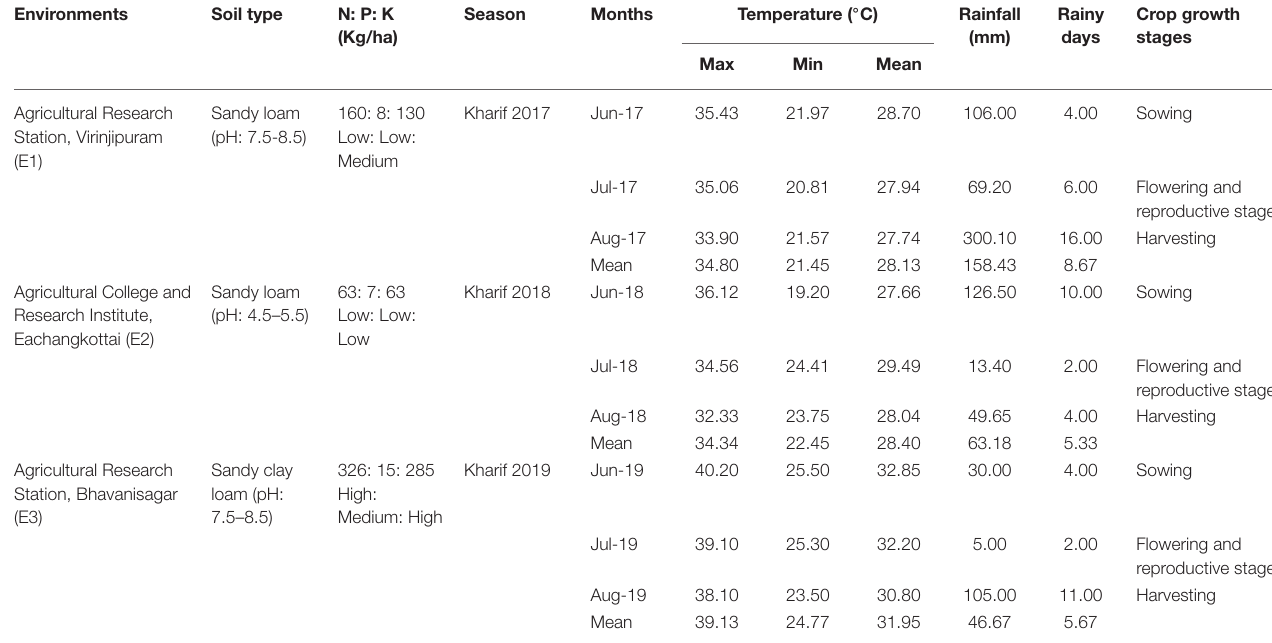
TABLE 1 | Weather parameters during crop growth stages.